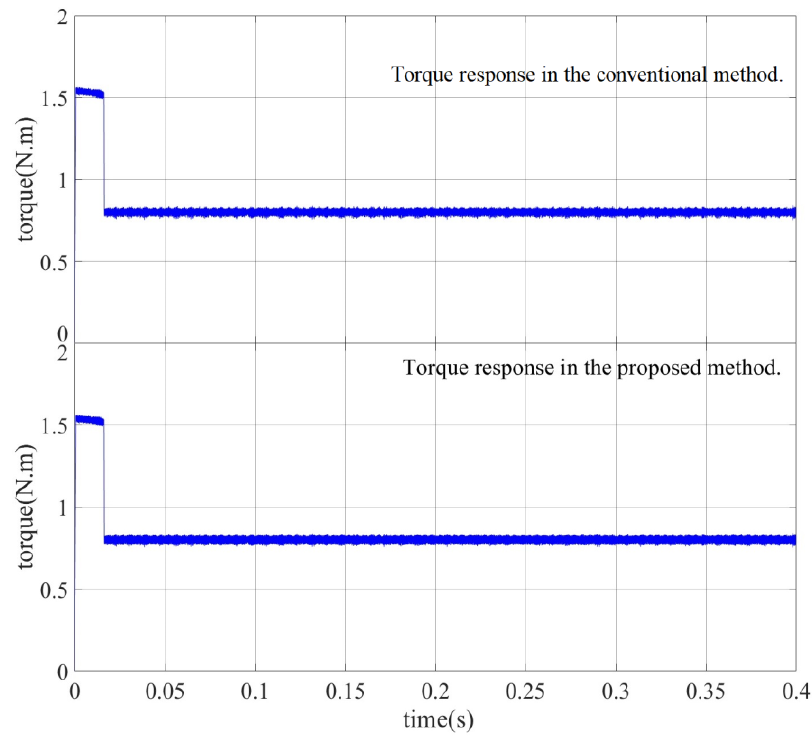
Figure 12. Torque response when the motor is under load.